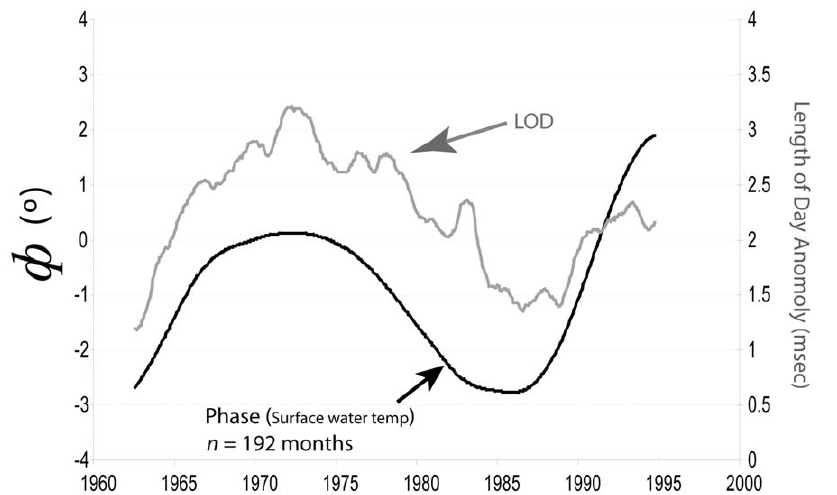
Figure 3. Annual seasonality phase anomaly ( W ( t ,192)) plotted with the deviation in length of day (LOD). LOD is presented as smoothed values where the variances contributed by harmonics higher than an annual period were lowered to match the raw W ( t ,192) time series (see Methods). The strong relationship suggested by visual inspection is supported by a high maximum cross-correlation coefficient between pre- whitened time series of 0.507 with no lag. Data were continuous from January 18 th , 1963 to December 31 st , 2003 (40 years).